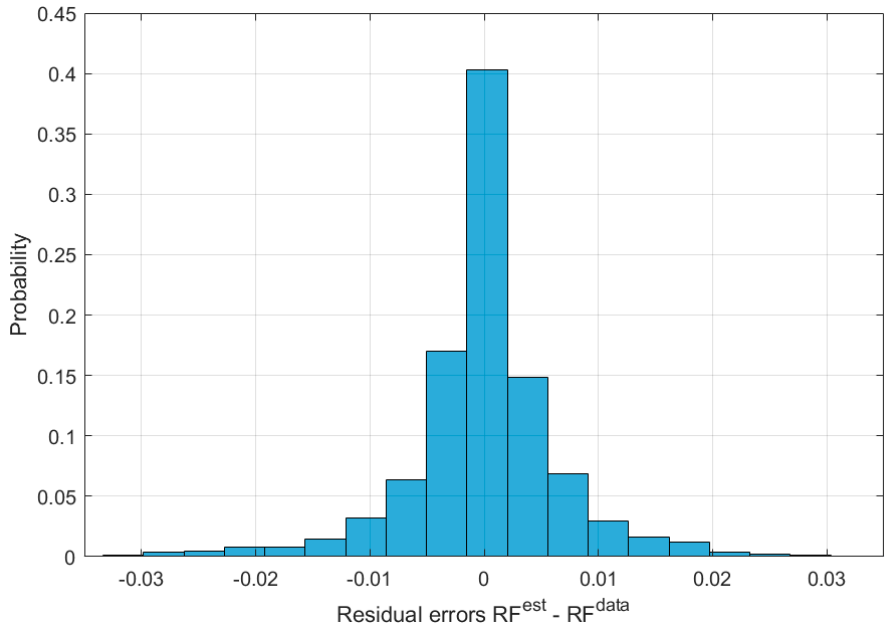
Figure 7. Histogram of residual errors (estimated RF minus actual RF ) for the total dataset based on MOD2 (optimized LSSVM model). Partial derivatives with respect to each normalized variable, (cid:3105)(cid:3052) , were calculated for (cid:3105)(cid:3051) (cid:3263)(cid:3284) each data point using MOD2 and histograms were created for each variable, as shown in Figure 8. The derivatives were calculated numerically and two choices of Δ𝑥 (cid:3015) (cid:3404) 5 ⋅ 10 (cid:2879)(cid:2870) and 10 (cid:2879)(cid:2871) were used. The two choices produced practically identical histograms, suggest ‐ ing that the optimized LSSVM function did not suffer from oscillations (a sign of over ‐ fitting). For each variable, a large fraction of the points featured positive and negative derivatives. Hence, changing the variable can affect RF positively or negatively, indicating coupling and room for finding optimal conditions. For (cid:3105)(cid:3052) (cid:3105)(cid:3051) (cid:3263)(cid:3117) we see positive and negative values, which is reasonable, since RF should be higher for WAG than single ‐ phase injection. (cid:3105)(cid:3052) (cid:3105)(cid:3051) (cid:3263)(cid:3121) and (cid:3105)(cid:3052) (cid:3105)(cid:3051) (cid:3263)(cid:3122) are both dominated by negative values, since increasing the mobility ratio between gas and oil or between water and oil, respectively, should reduce RF. Higher water–oil gravity segregation is consid ‐ ered negative for RF, with (cid:3105)(cid:3052) (cid:3105)(cid:3051) (cid:3263)(cid:3123) mainly negative. On the other hand, gas–oil gravity seg ‐ regation is considered mainly positive for RF with a majority of points having (cid:3105)(cid:3052) (cid:3105)(cid:3051) (cid:3263)(cid:3124) posi ‐ tive. This could be attributed to the better sweep of low ‐ permeable layers in heterogene ‐ ous cases. Hysteresis appears to benefit recovery, as seen by a majority of positive (cid:3105)(cid:3052) (cid:3105)(cid:3051) (cid:3263)(cid:3119) , although the effect of (cid:3105)(cid:3052) (cid:3105)(cid:3051) (cid:3263)(cid:3120) seems to be equally negative and positive.